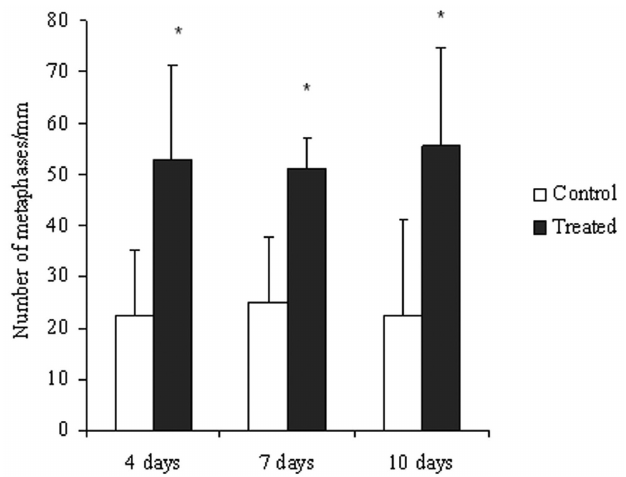
FIGURE 1 - Effect of treatment of cutaneous wounds after 4, 7 and 10 days with ointment containing 1% ethyl-acetate fraction from stem bark of S. adstringens on the number of metaphases/mm in the newly formed epithelium. Mean ± S.D. (n=5), *P<0.05 compared to the